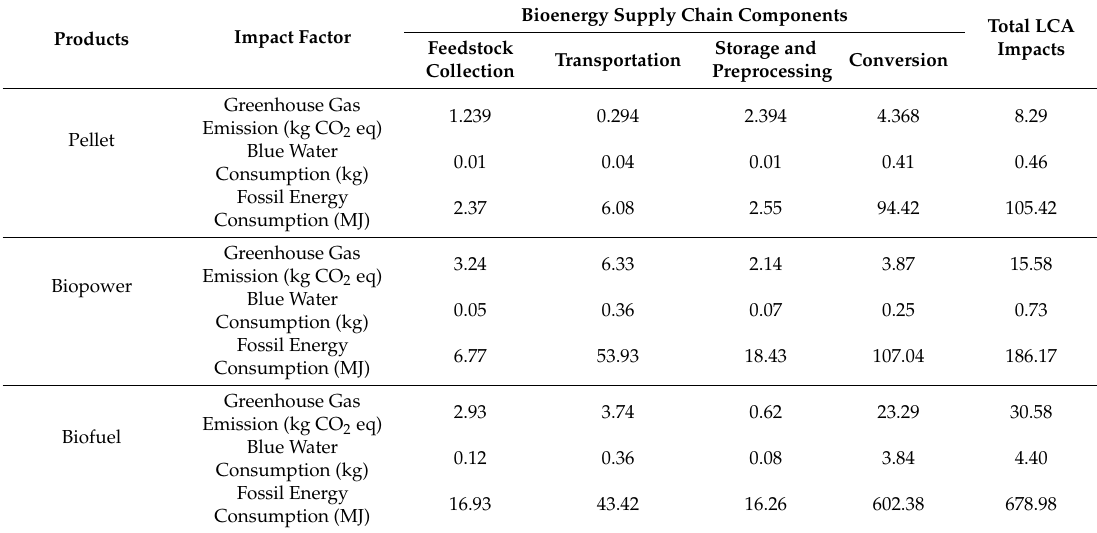
Table 3. Life-cycle assessments (LCA) for bioenergy production: pellet, biopower, and biofuel.